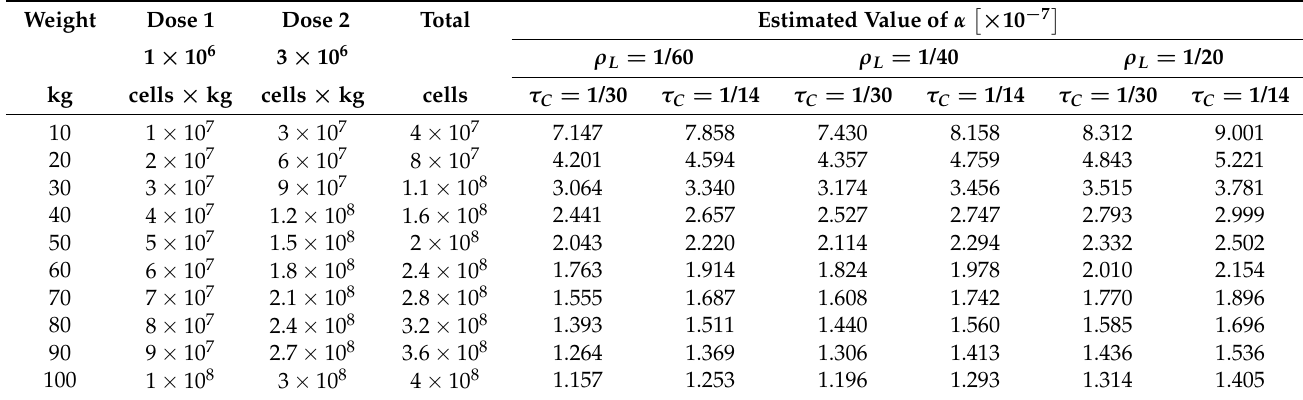
Table 2. Estimated values for the α parameter in order to achieve CR in a patient by day 28 after the two doses of CAR-T cells therapy on days 0 [ dose 1 ] and 7 [ dose 2 ] . As the total dose applied depends on the weight of the patient, values are estimated for 10 kg to 100 kg. In silico experimentations were performed for two values of the natural death rate of CAR-T cells [ τ C ] , and three values of the cancer cells growth rate [ ρ L ] . For the maximum tumour carrying capacity and the mitosis stimulation rate of CAR-T cells only one value was considered. Note that all results of α are in the order of 10 − 7 . Weight